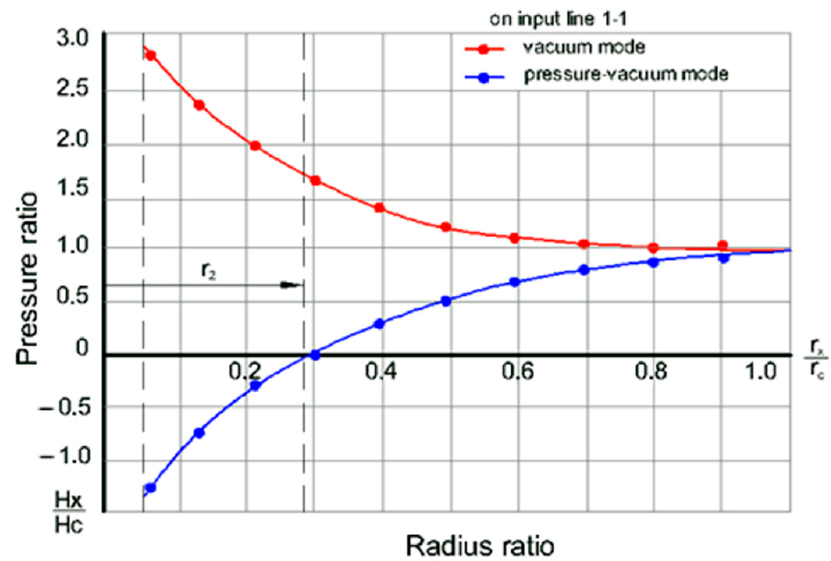
Figure 2. Dependency graphs H_x/H_1 = f(r_x/r_h).